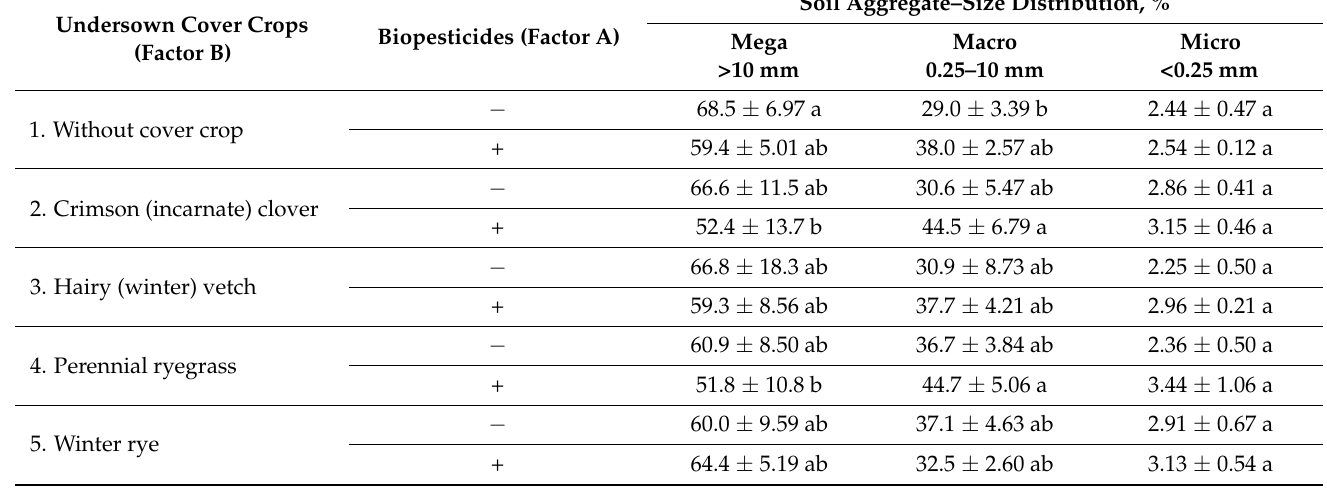
Table 1. Soil aggregate–size distribution,